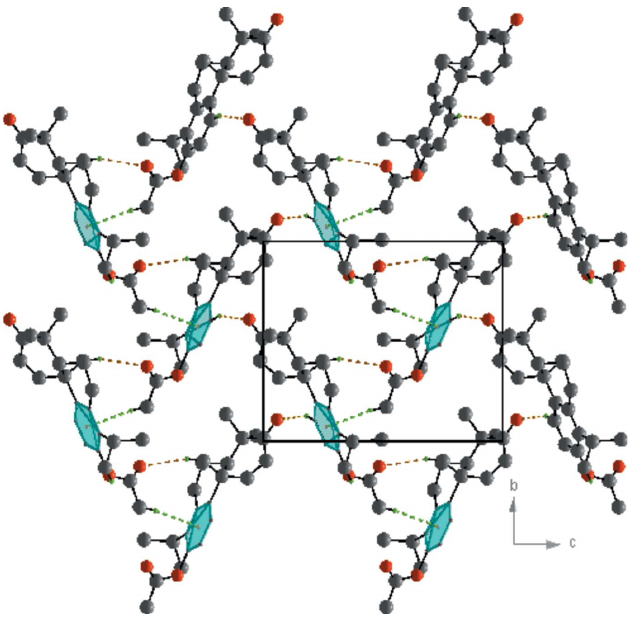
Figure 3 A view along the a axis of the crystal packing of the title compound, showing the C—H (cid:2)(cid:2)(cid:2) O hydrogen bonds (orange dashed lines) and C— H (cid:2)(cid:2)(cid:2) (cid:2) interactions (green dashed lines). For clarity, only the H atoms involved in these interactions have been